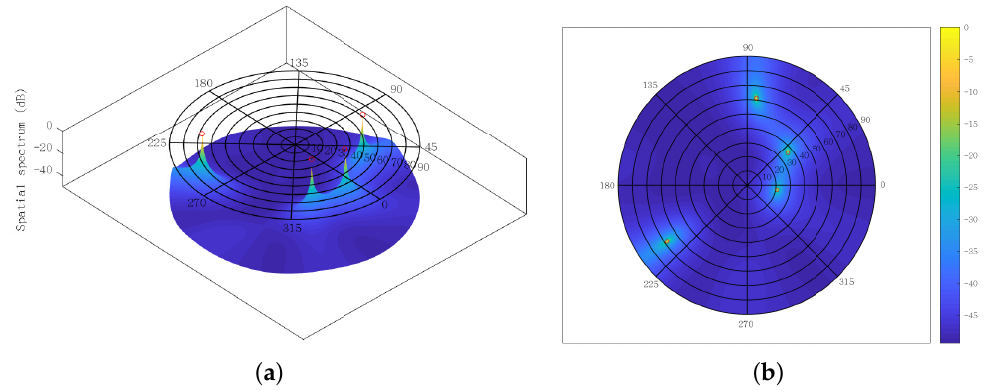
Figure 13. RMSE versus SNR, K . D = 5: ( a ) RMSE versus SNR, K = 1024; ( b ) RMSE versus K , SNR = 15 dB.